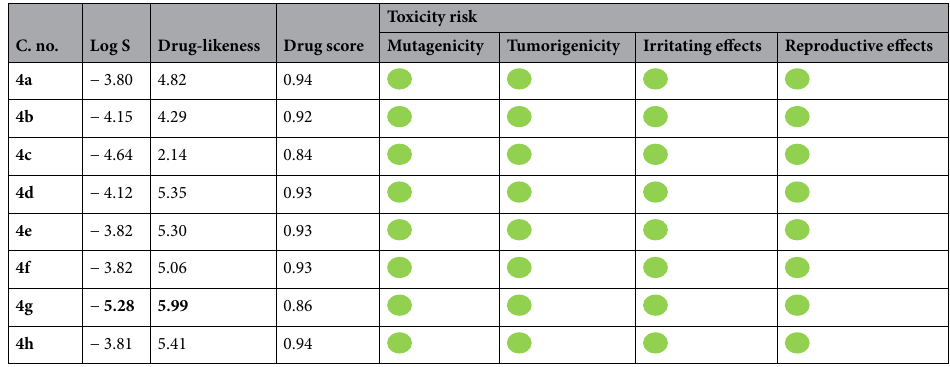
Table 3. Toxicity risks, drug-likeness, and drug score for tested compounds 4 a–h . LogS -Solubility parameter, Low toxicity risk.